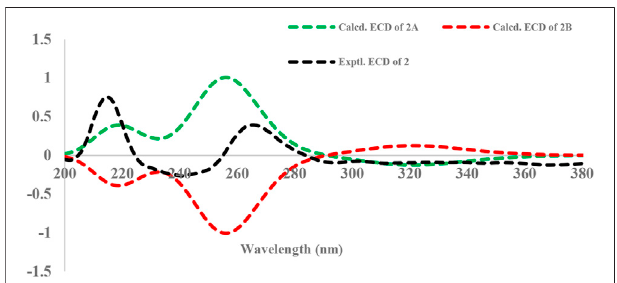
FIGURE 5 | Experimental and calculated ECD spectra of